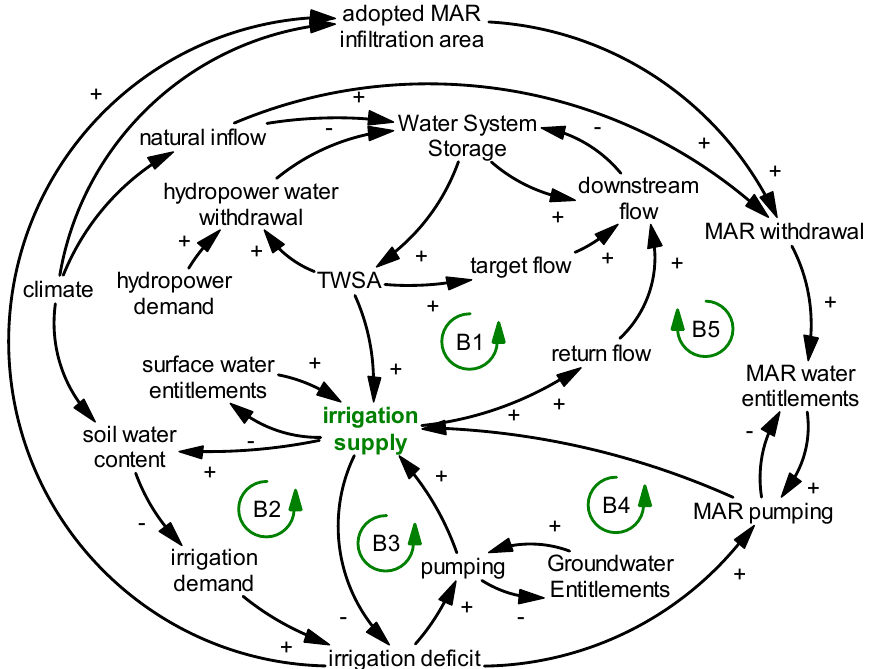
Figure 4. Causal loop diagram for water management system. The ‘+’ sign with the arrow indicates two variables changing in the same direction, and the ‘ − ’ sign indicates the opposite direction. Balancing loops (negative feedback, labeled as ‘B’) balance the system over time, negating the impact of the disturbance. B1–B5 are five balancing loops that illustrate the effects on irrigation supply.